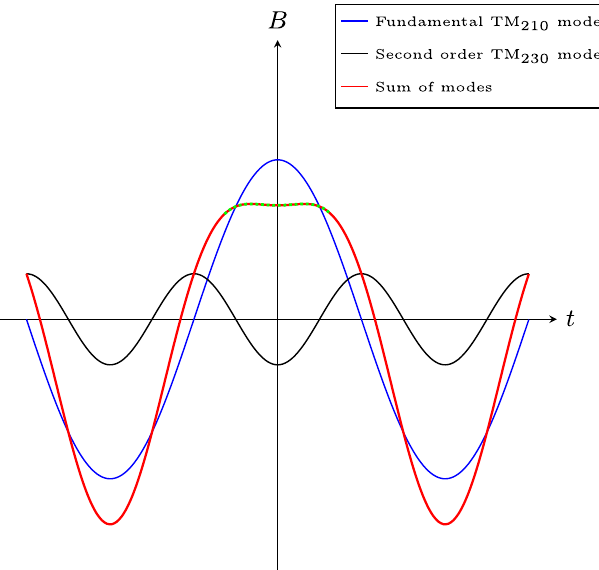
FIG. 5. The time-dependent magnetic field in the center of the chopping cavity. The dashed green line represents the field probed by an electron